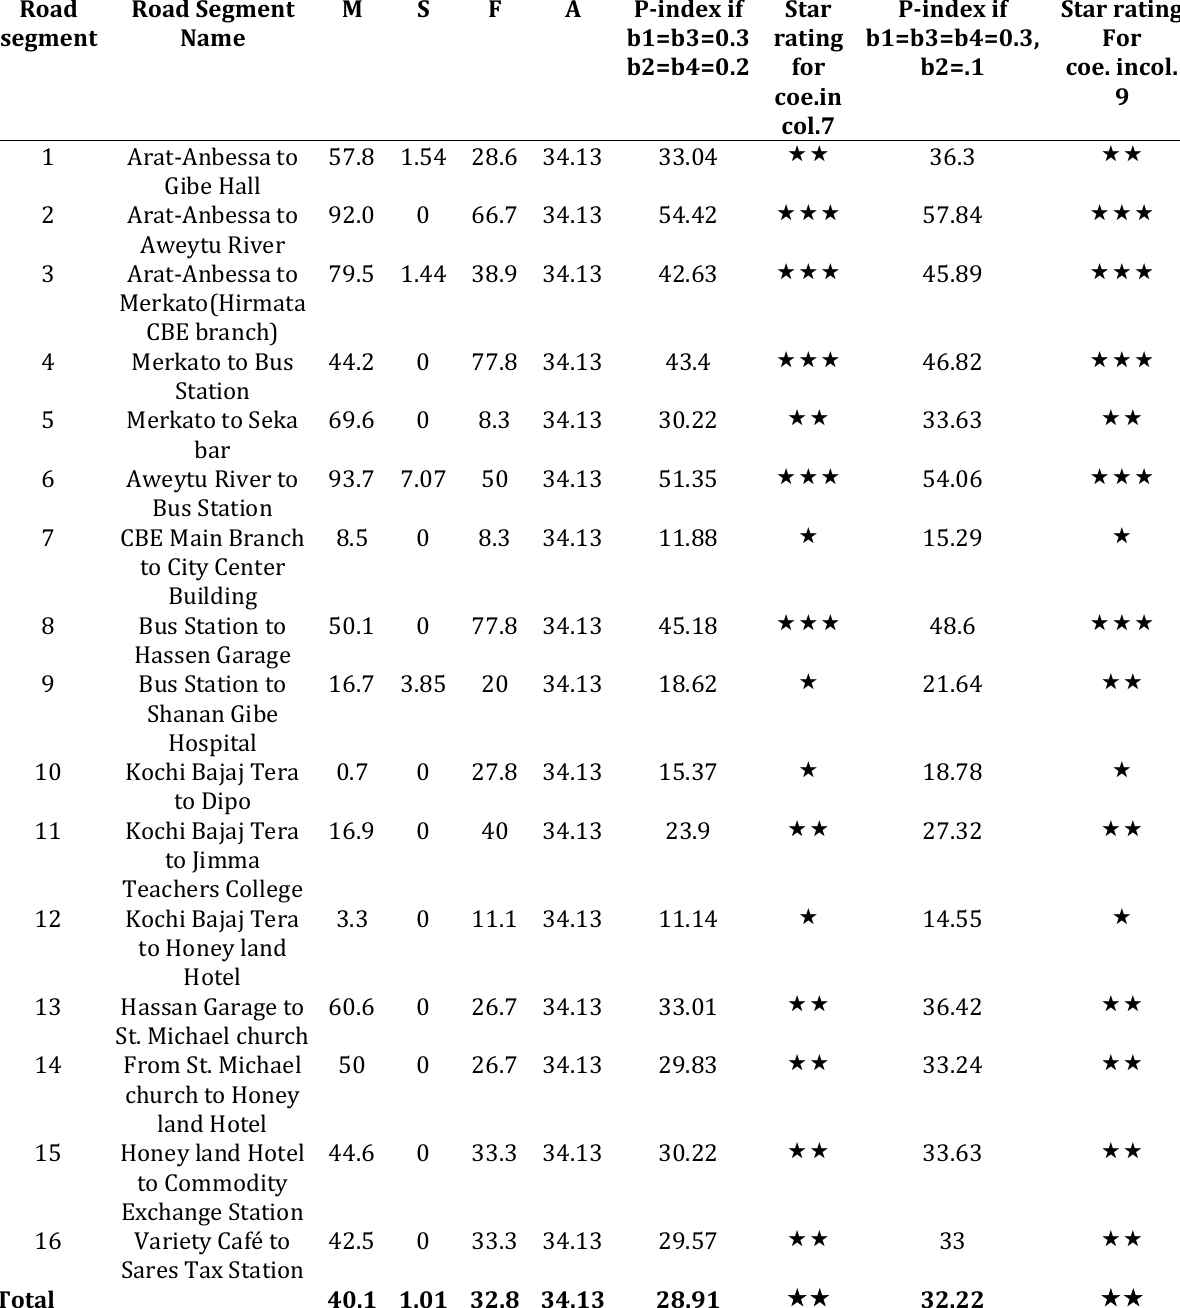
Table 10: Values of the P-index and the corresponding star rating of the selected road segments with the various coefficients of the four indicators Road Road segment